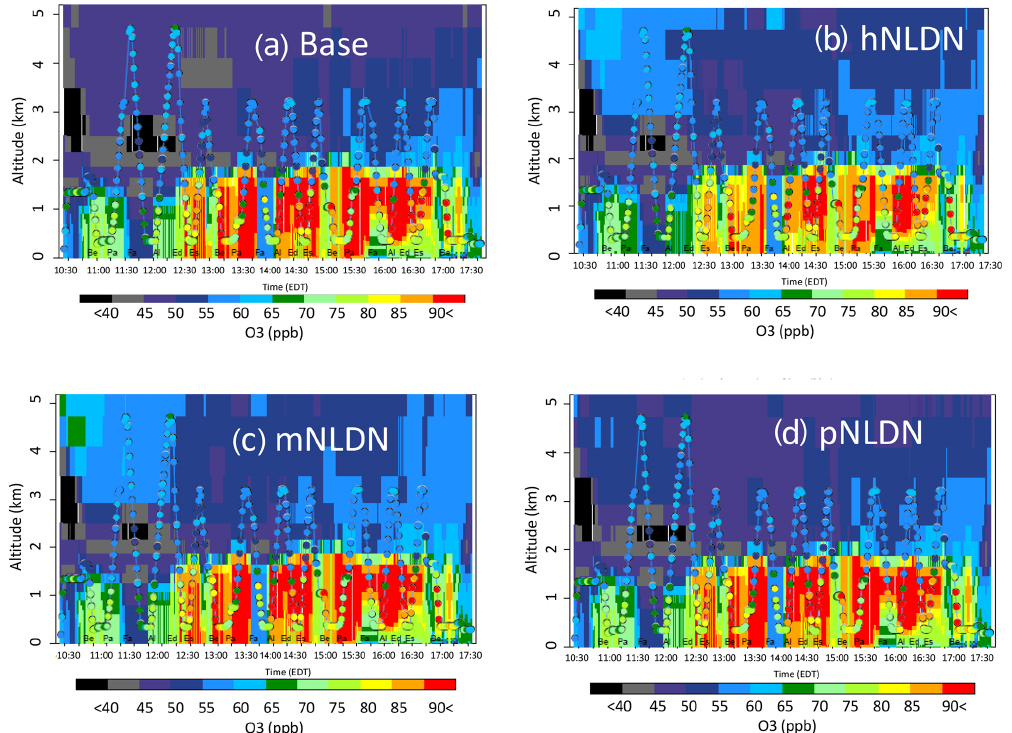
Figure 7. Overlay of P-3B-observed O 3 (1min mean values) over the corresponding vertical cross sections of simulated values extracted at the flying locations on 28 July 2018, (a) Base, (b) hNLDN (c) mNLDN, and (d) pNLDN. The letters marked at the bottom of the plots are P-3B spiral sites, Be: Beltsville, Pa: Padonia, Fa: Fair Hill, Al: Aldino, Ed: Edgewood, and Es: